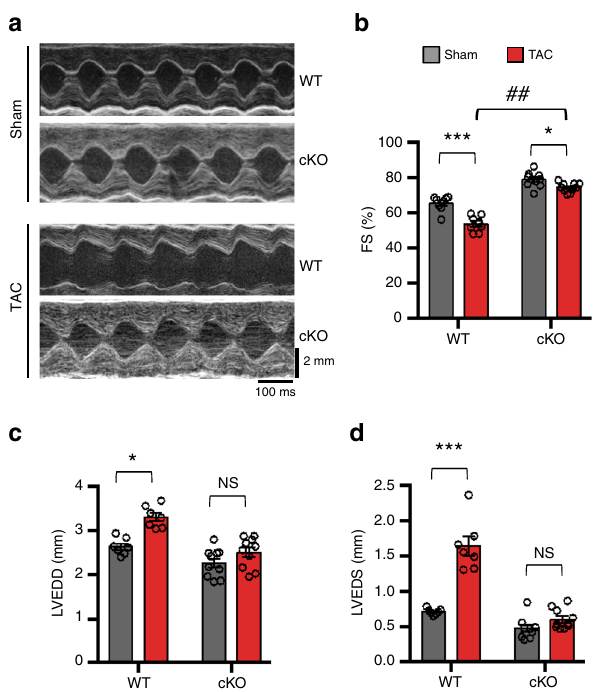
Fig. 5 FoxO1-cKO hearts manifest preserved contractile function in response to TAC. a Representative M-mode tracings of 3-week sham- and TAC-operated hearts of FoxO1-WT (WT) and FoxO1-cKO (cKO) mice. b Percent of left ventricular fractional shortening (%FS) of WT ( n = 16) and cKO ( n = 20). c Left ventricular end-diastolic diameter (LVEDD, mm) of WT ( n = 14) and cKO ( n = 20), and d Left ventricular end-systolic diameter (LVESD, mm) of WT ( n = 14) and cKO ( n = 19) are shown. Note that cKO mice do not manifest contractile dysfunction when compared with WT littermates TAC heart. In all panels, data are depicted as mean ± SEM. * p < 0.01 vs sham; *** p < 0.001 vs sham; ## p < 0.0001 vs cKO; NS not statistically signi fi cant. Statistical analyses were conducted using a two- tailed, unpaired Student ’ s t -test.